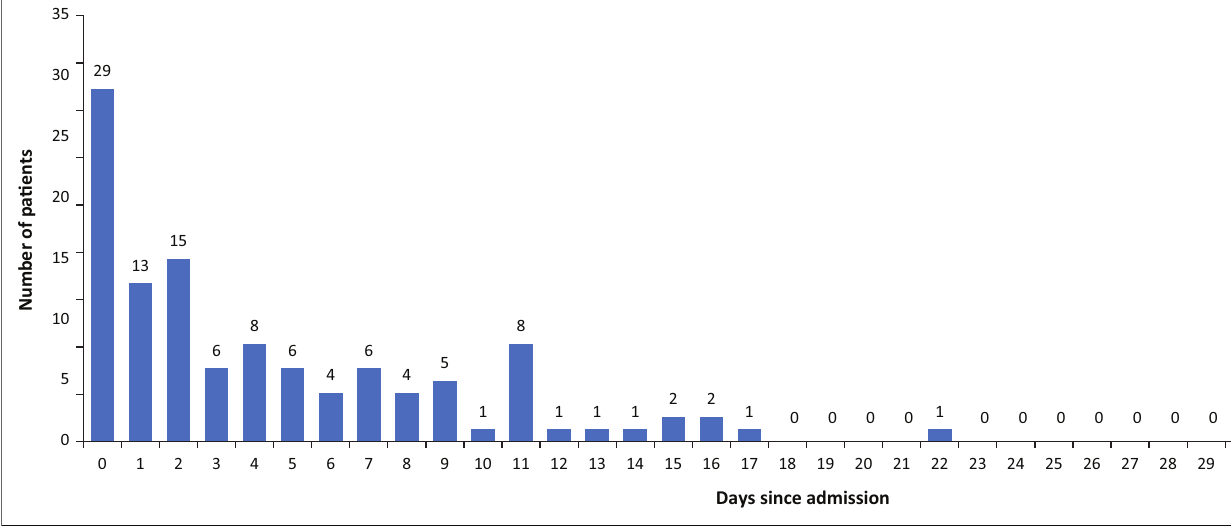
FIGURE 3: Timing of death since the day of admission. N =